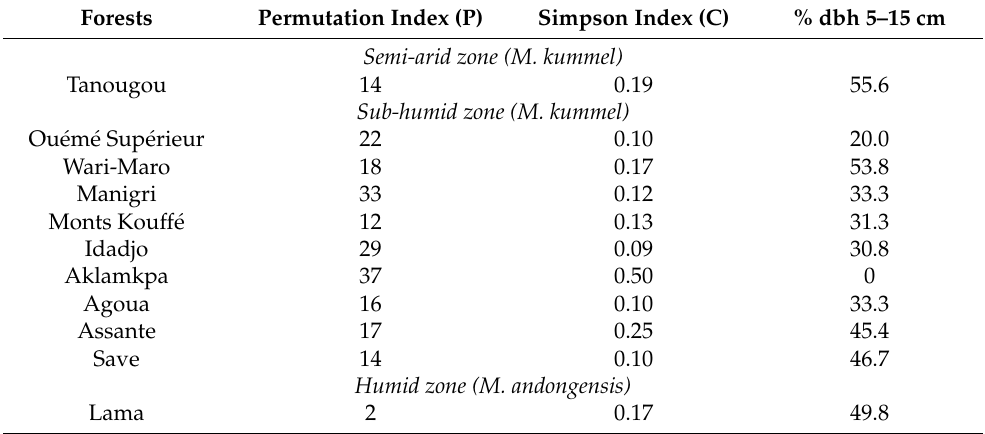
Table 7. Permutation and Simpson indices and percentage of smallest size classes in the investigated